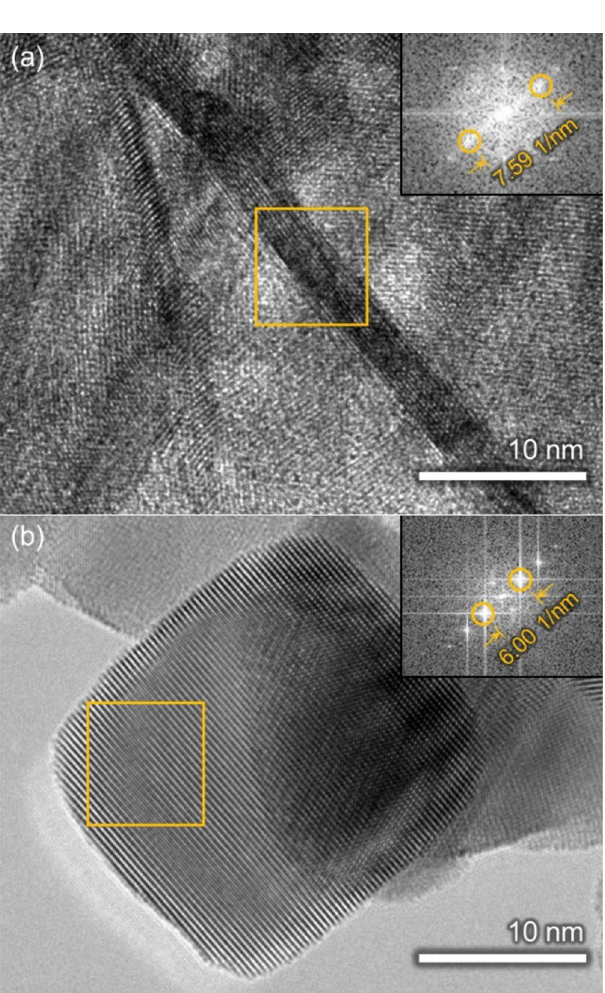
Figure 2. Transmission electron microscopy (TEM) images of ( a ) nanosheet-type tin oxide and ( b ) commercial tin oxide nanoparticle with corresponding fast Fourier transform (FFT)